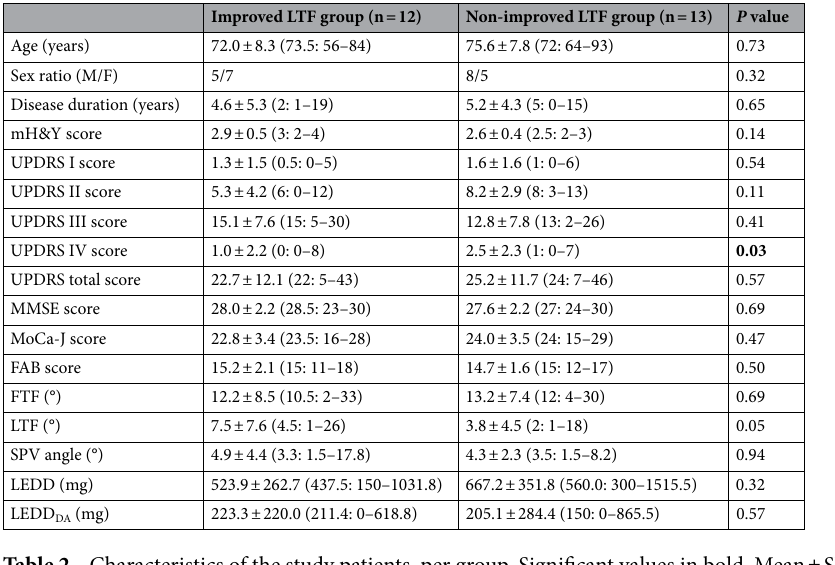
Table 2. Characteristics of the study patients, per group. Significant values in bold. Mean ± SD (median: range) values are shown, unless otherwise indicated. mH&Y modified Hoehn and Yahr stage, UPDRS Unified